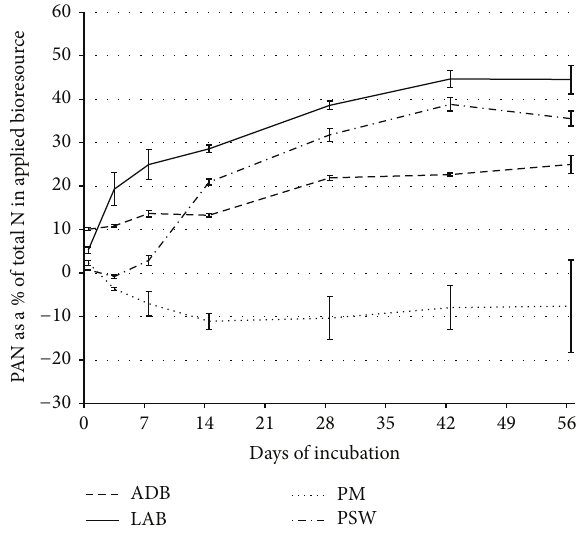
Figure 3: PAN (NO 3− + NH 4+ ) of treated soils (dry weight) as percentage of total N of added amendment (error bars are standard error of the means). Corrected for PAN in control